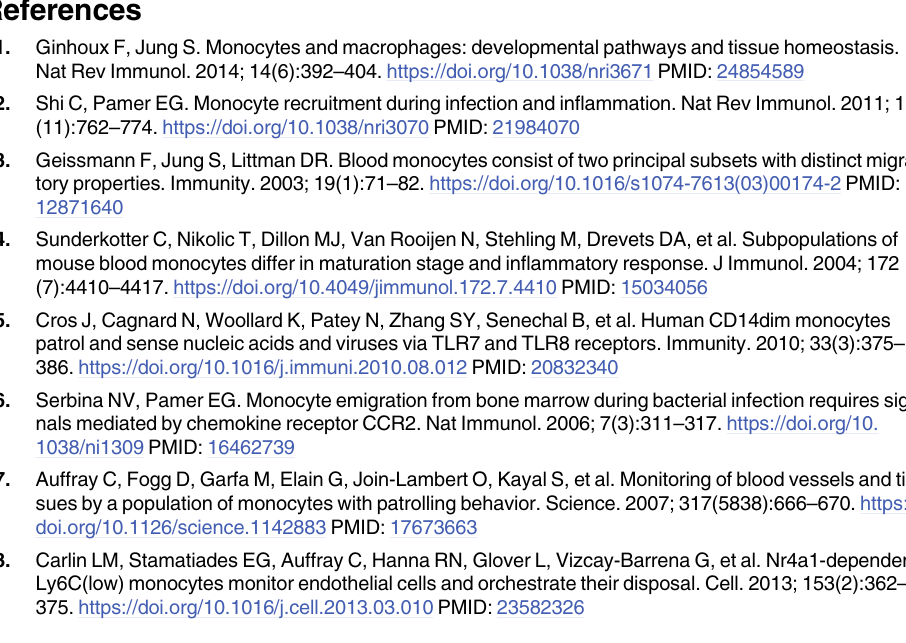
S11 Video. IVM video showing that a monocyte (green) was crawling in the brain capillary and adopting a rod-shaped morphology when passing through the capillary in CX3CR1 gfp/+ mice 18 h after infection with 20x10 6 C . neoformans .